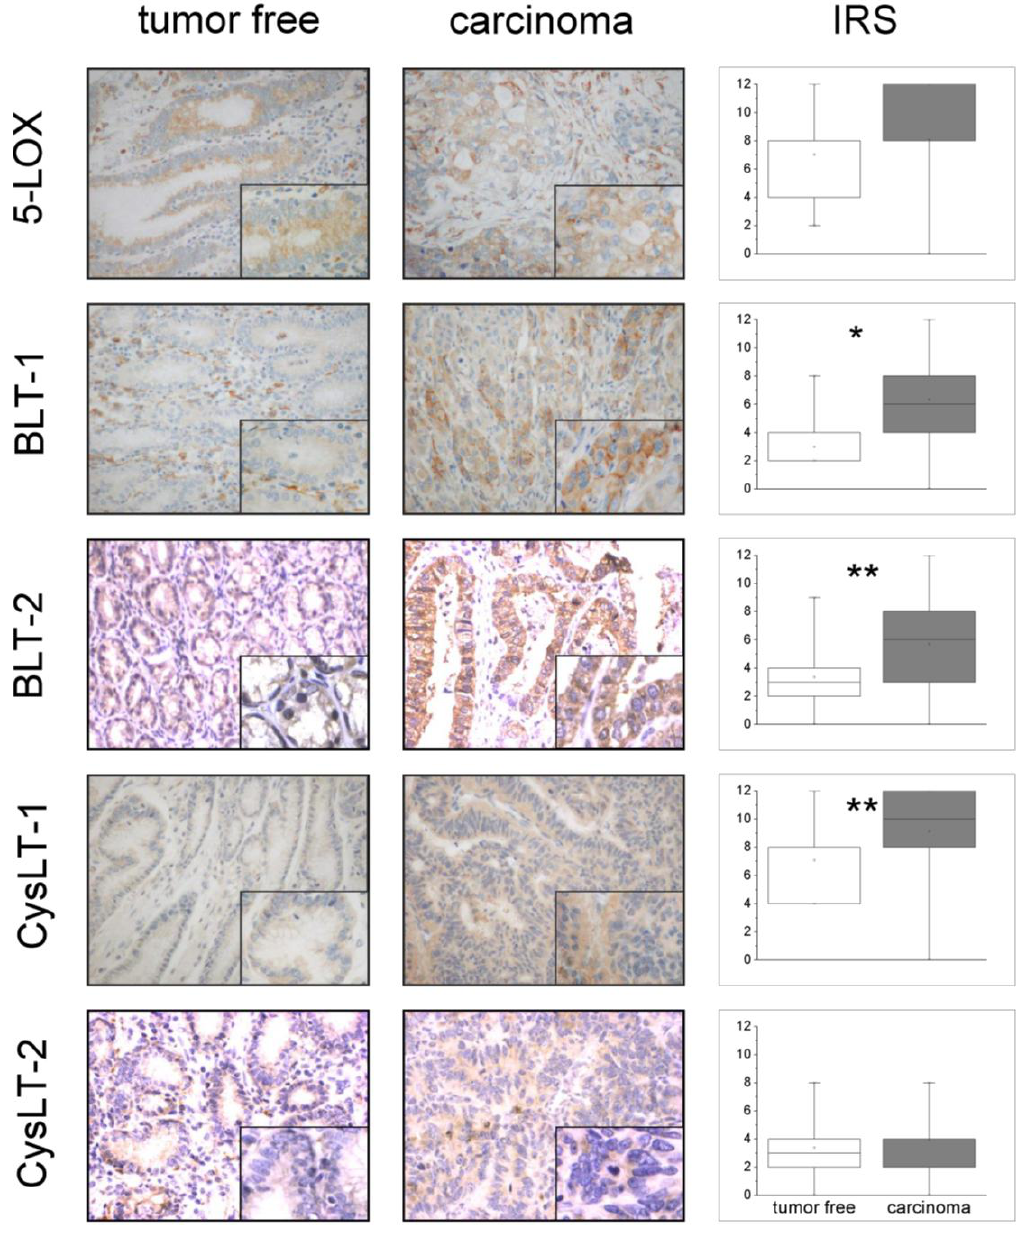
Figure 1. Immunohistochemical (IHC) expression of 5-LOX, BLT-1, BLT-2, CysLT-1, CysLT- 2 in GC and tumor-free gastric mucosa. On the left side of the figure are shown IHC staining patterns from tumor-free gastric mucosa and GC specimens, respectively. Each slide displays a representative section of the gastric surface epithelium at low (whole image) and high magnification (right lower corner). Signals illustrating 5-LOX, BLT-1, BLT-2, CysLT-1, CysLT-2 appear in brown (microscope: Nikon F200 camera, Nikon coolpix 990; 100×, 400×). On the right side of the figure is shown the IHC expression of 5-LOX and LT-receptors in the tumor-free gastric mucosa and GC, respectively. Values are presented as box plot graphics where each box plot shows the location of the median (marked line), mean (open square) and the 25 th and 75 th quartiles (inferior and superior limit of boxes). IRS: immunoreactive score. * denotes p < 0.01 (BLT-1), ** denotes p < 0.001 (BLT-2 and CysLT-1) (Mann-Whitney